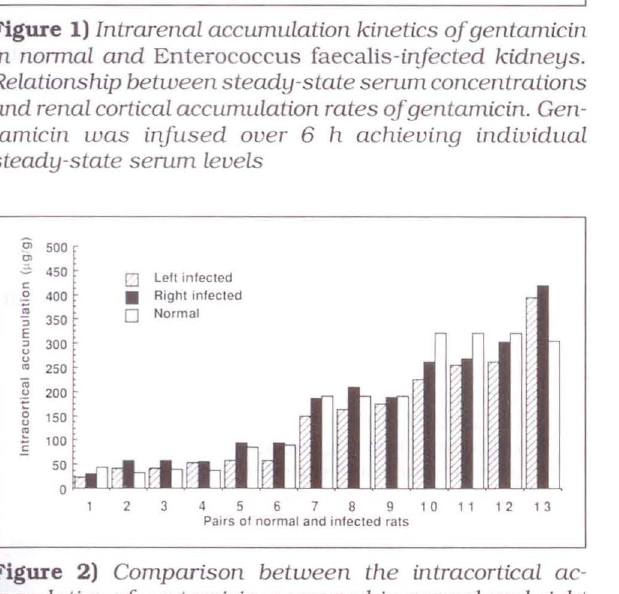
Figure 2) Comparison between the intracortical ac cumulation of gentamicin measured in normal and right and left infected kidneys. Normal and infected animals were paired on the basis of body weight and steady-state serum levels (not more than 20% variation for each parameter between normal and infected rats) normal animals was (x=3 h, y=6 h): y=-0.27 +l.18x; r=0.97; n=22. The correlation for infected animals was y=0.71+0.95x; r=0.93; n=23. Intracortical accumulation kinetics: Steady state elevation of serum concentrations (S) of gen tamicin was associated with a linear increase of cortical accumulation rate M in normal and in right and left infected kidneys (Figure 1). The linear regression and slope of these three curves were not significantly different: normal kidneys V=2.65S+8.19, r=0.94, n=22: right infected kid neys V=2.93S+8.00, r=0.9l, n=23; left infected kidneys V=2.66S+6.87, r=0.91 , n=23. Intracortical accumulation: The correlation be tween gentamicin concentrations measured in right (R) and left (L) infected kidneys over the whole range of serum levels was: L=0.34+0.87R r=0.98. n=23. No significant difference was observed be tween the accumulation of gentamicin in right and left infected